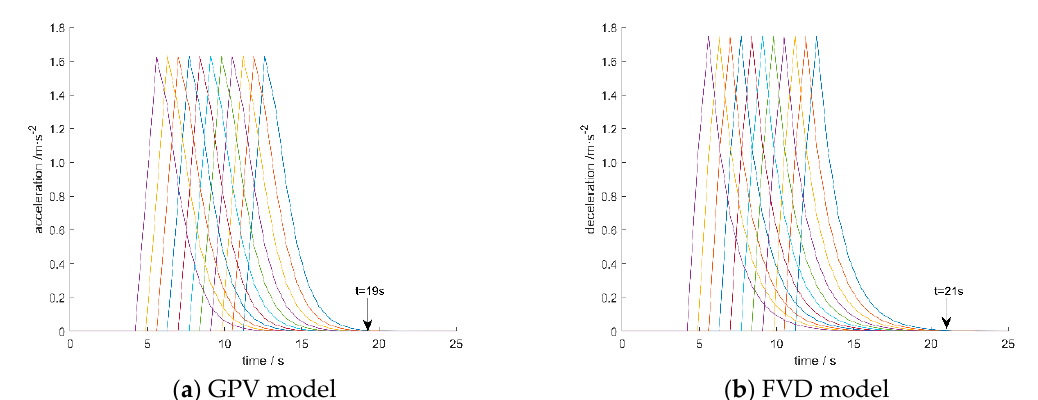
Figure 7. Comparison of acceleration during the starting process between the two models.